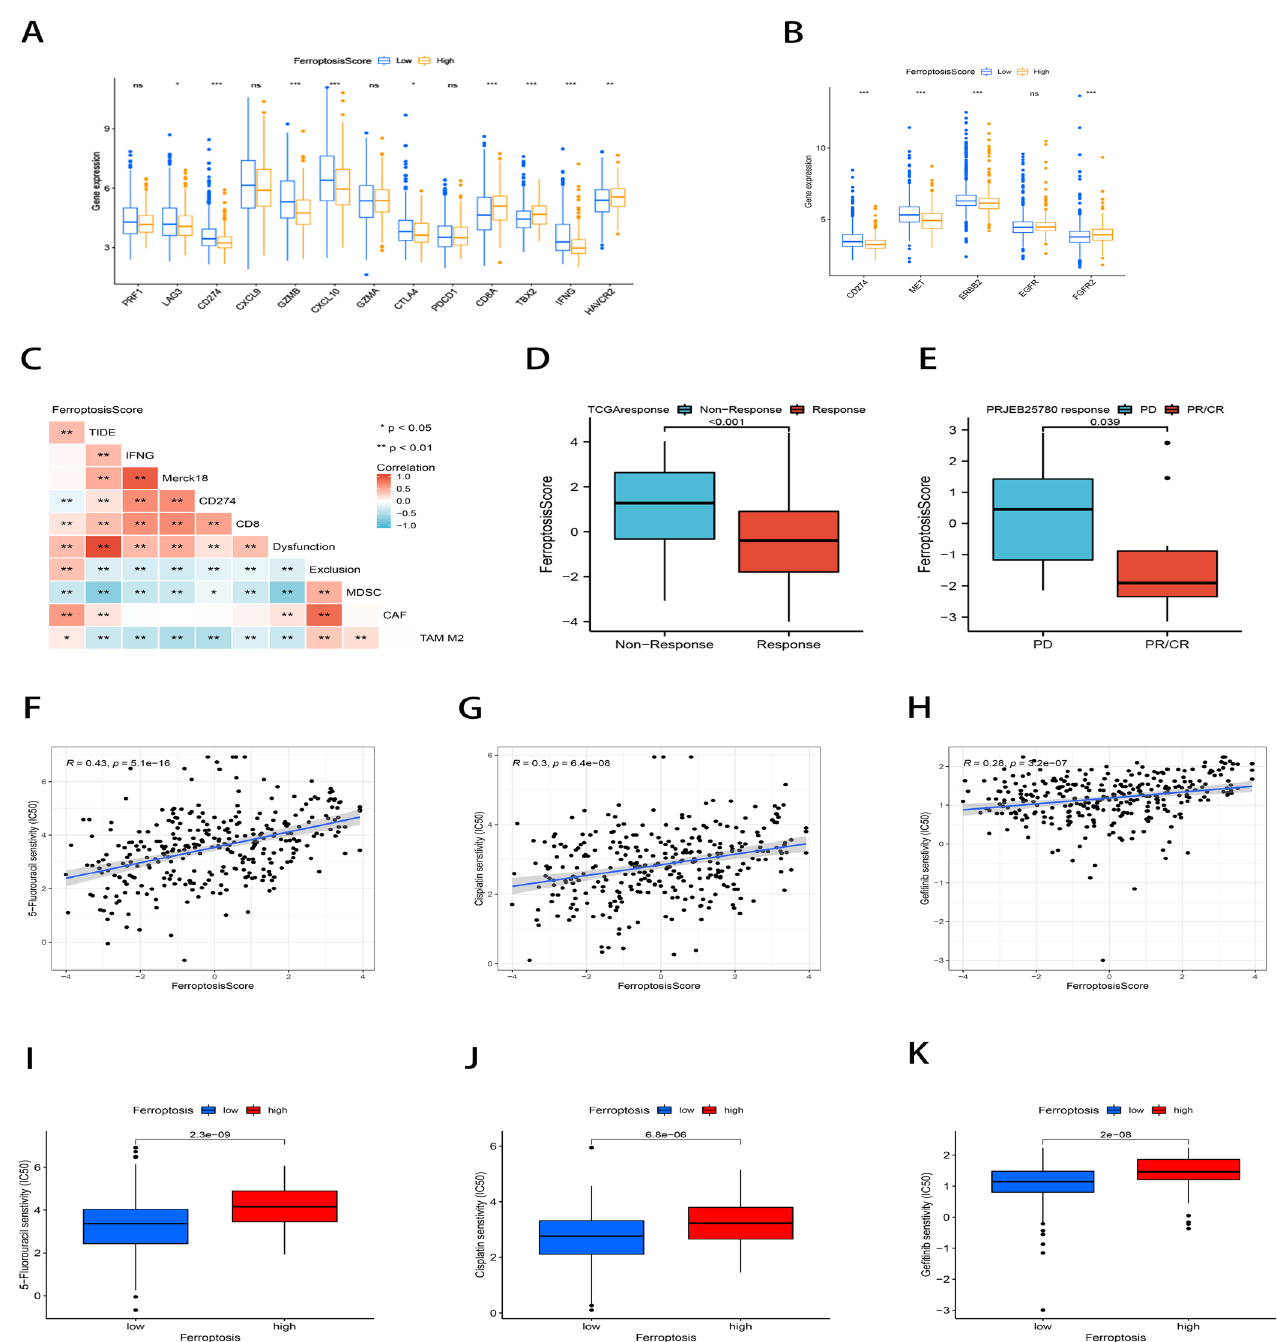
Figure 8. Ferroptosis score correlated with immunotherapy efficacy and chemotherapy drug sensitiv- ity prediction. ( A , B ) Box plots depicting the relative expression differences of checkpoints ( A ) and common targets of gastric cancer ( B ) between ferroptosis score groups. ns: not significant; * p < 0.05; ** p < 0.01; *** p < 0.001. ( C ) Correlation heat map demonstrating the association of ferroptosis scores with TIDE scores. ( D , E ) Differences in ferroptosis scores between the ICB treatment response and non-response groups in the TCGA cohort ( D ) and PRJEB25780 cohort ( E ). ( F – H ) Correlation of ferroptosis scores with chemotherapeutic drug sensitivity, including 5-fluorouracil ( F ), Cisplatin ( G ), Gefitinib ( H ). (I – K) Differences in chemotherapy drug sensitivity between ferroptosis score subgroups, including 5-fluorouracil ( I ), Cisplatin ( J ), and Gefitinib ( K ).